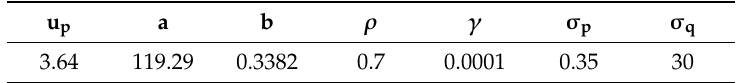
Table 2. Parameters setup with the wholesale log-price mean u P , the demand function intercept a, the demand function slope b, the wholesale log-price and quantity correlation ρ , the risk